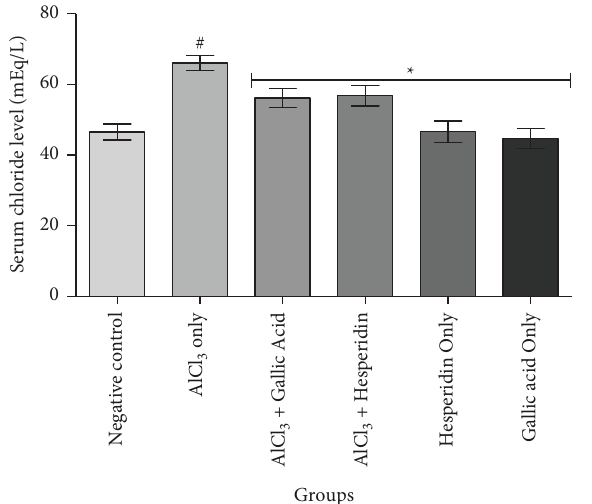
Figure 8: Effect of gallic acid and hesperidin on the serum bi- Figure 6: Effect of gallic acid and hesperidin on the serum chloride carbonate level in AlCl 3 -induced nephrotoxicity in Wistar rats. level in AlCl 3 -induced nephrotoxicity in Wistar rats. Values are Values are expressed as the mean ± standard deviation of six expressed as the mean ± standard deviation of six determinations. # p < 0 . 05 vs negative control, ∗ p < 0 . 05 vs. AlCl 3 only.